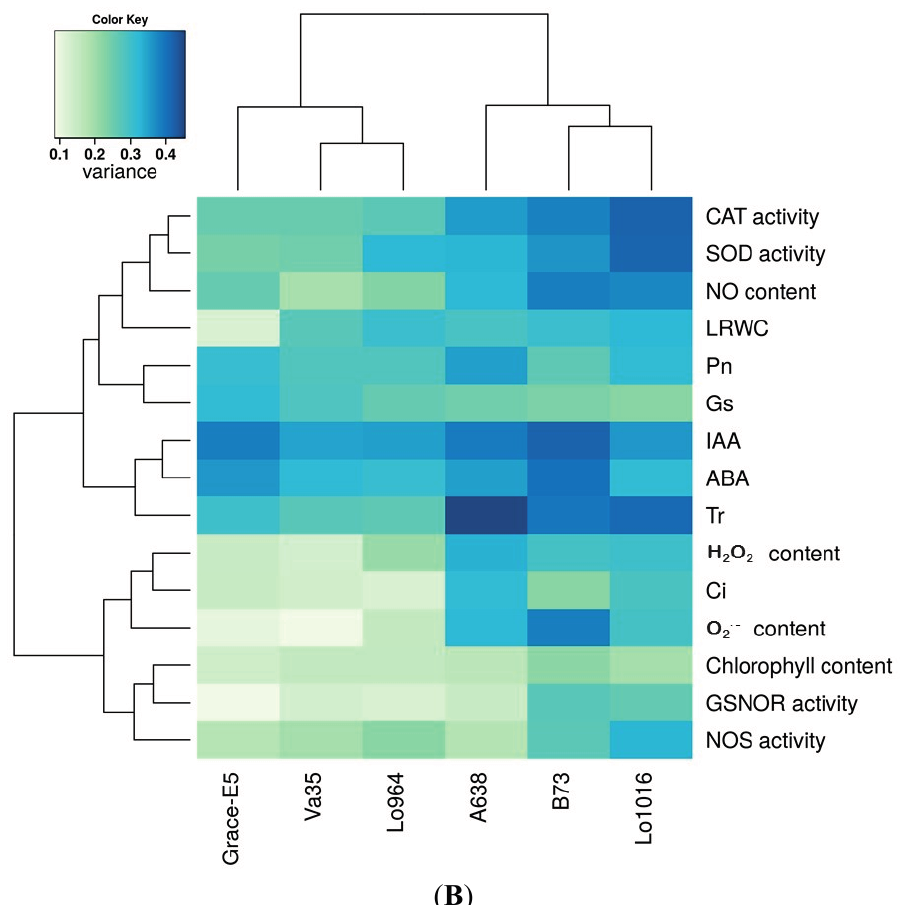
Figure 8. Correlation and variance analysis of all tested dataset in six tested lines under well-watered and drought treated conditions. ( A ) shows the correlation among each parameter determined; and ( B ) shows the variance among each trait and each sample during the period of drought